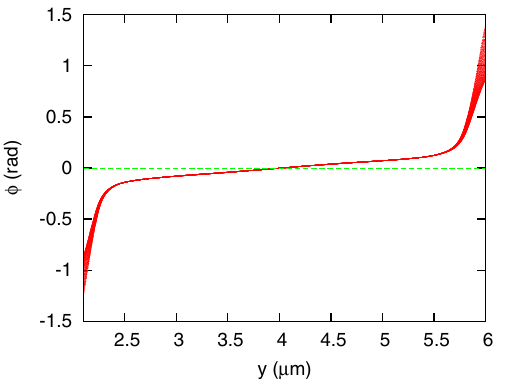
FIG. 7. The angular distribution of accelerated carbon ions versus the transversal position y .